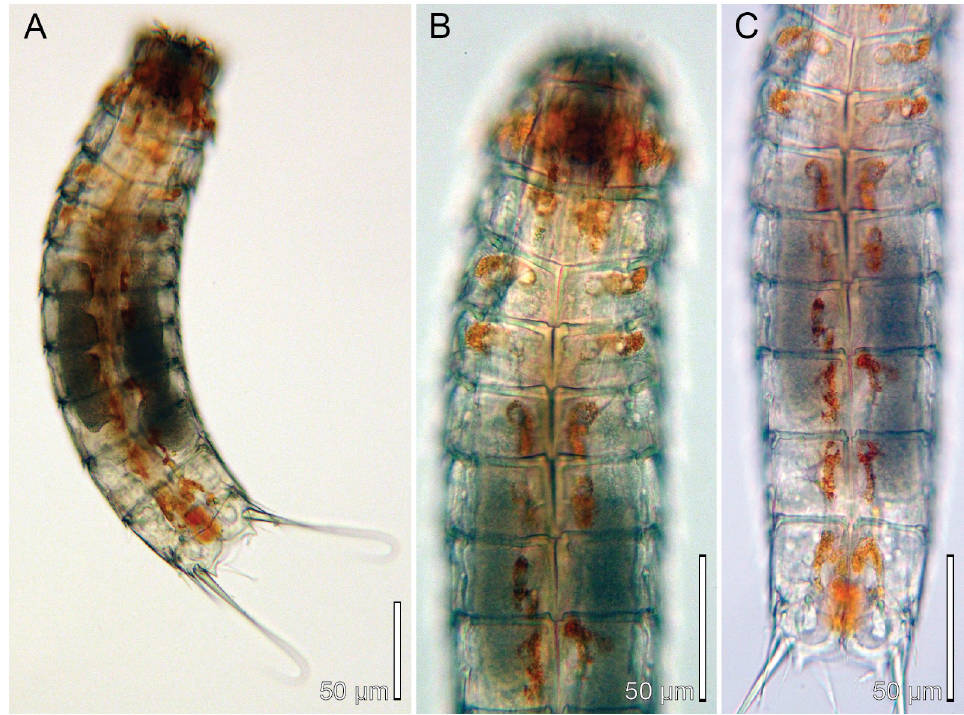
Fig. 11. Light micrographs showing overviews of live female of Echinoderes sensibilis Adrianov et al ., 2002 from Coconut Island, Oahu, Hawaii ( USNM-1616695). Note the brown-red glandular cells. DNA was subsequently extracted from the specimen and it is voucher for CO1 barcode sequence, GenBank Acc. number: